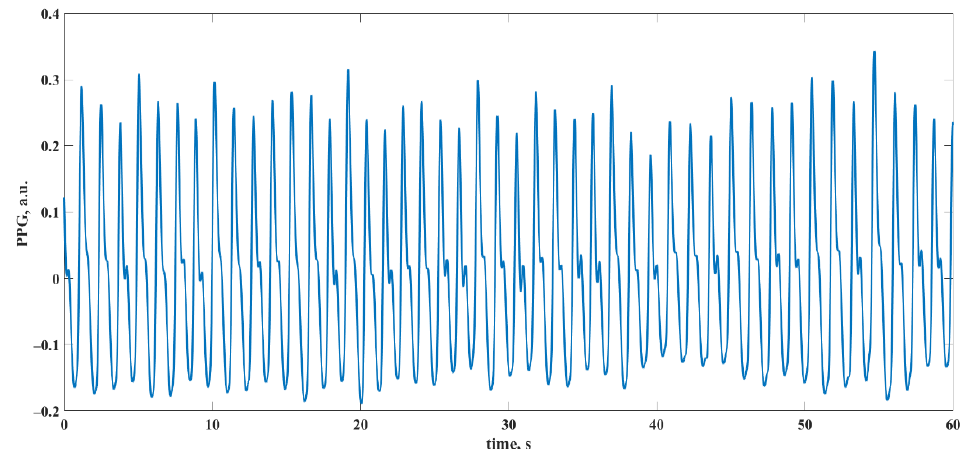
Figure 2. Example of a 60 s segment from a PPG recording.